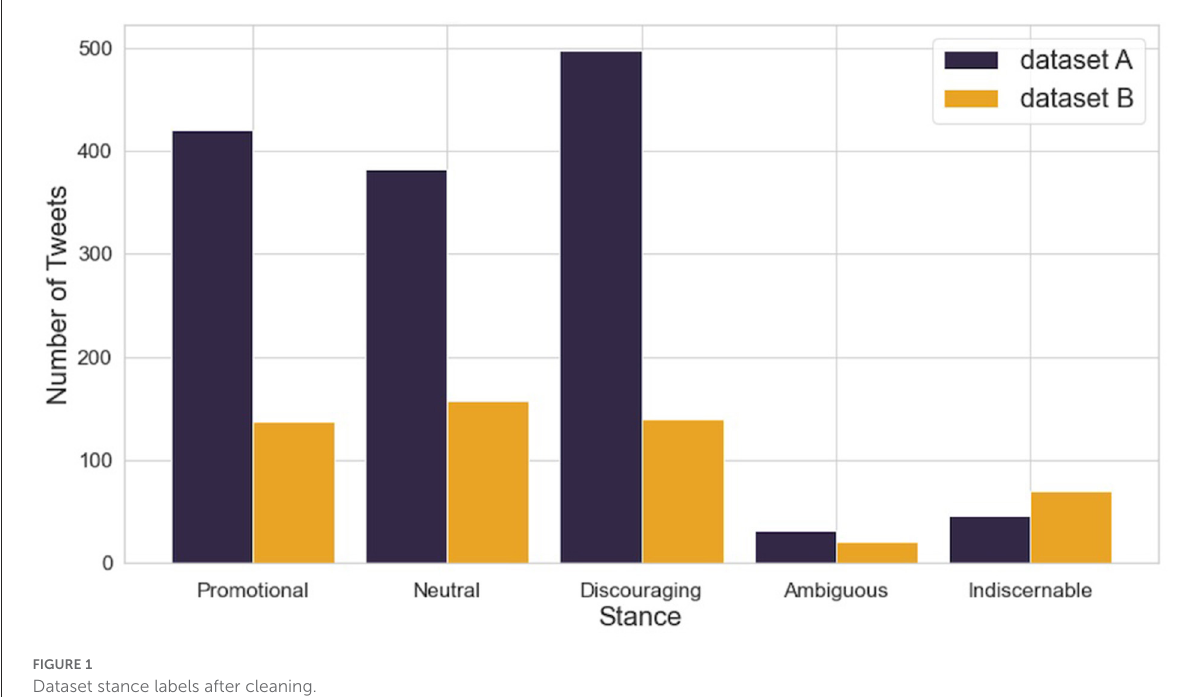
FIGURE1 Dataset stance labels after cleaning.